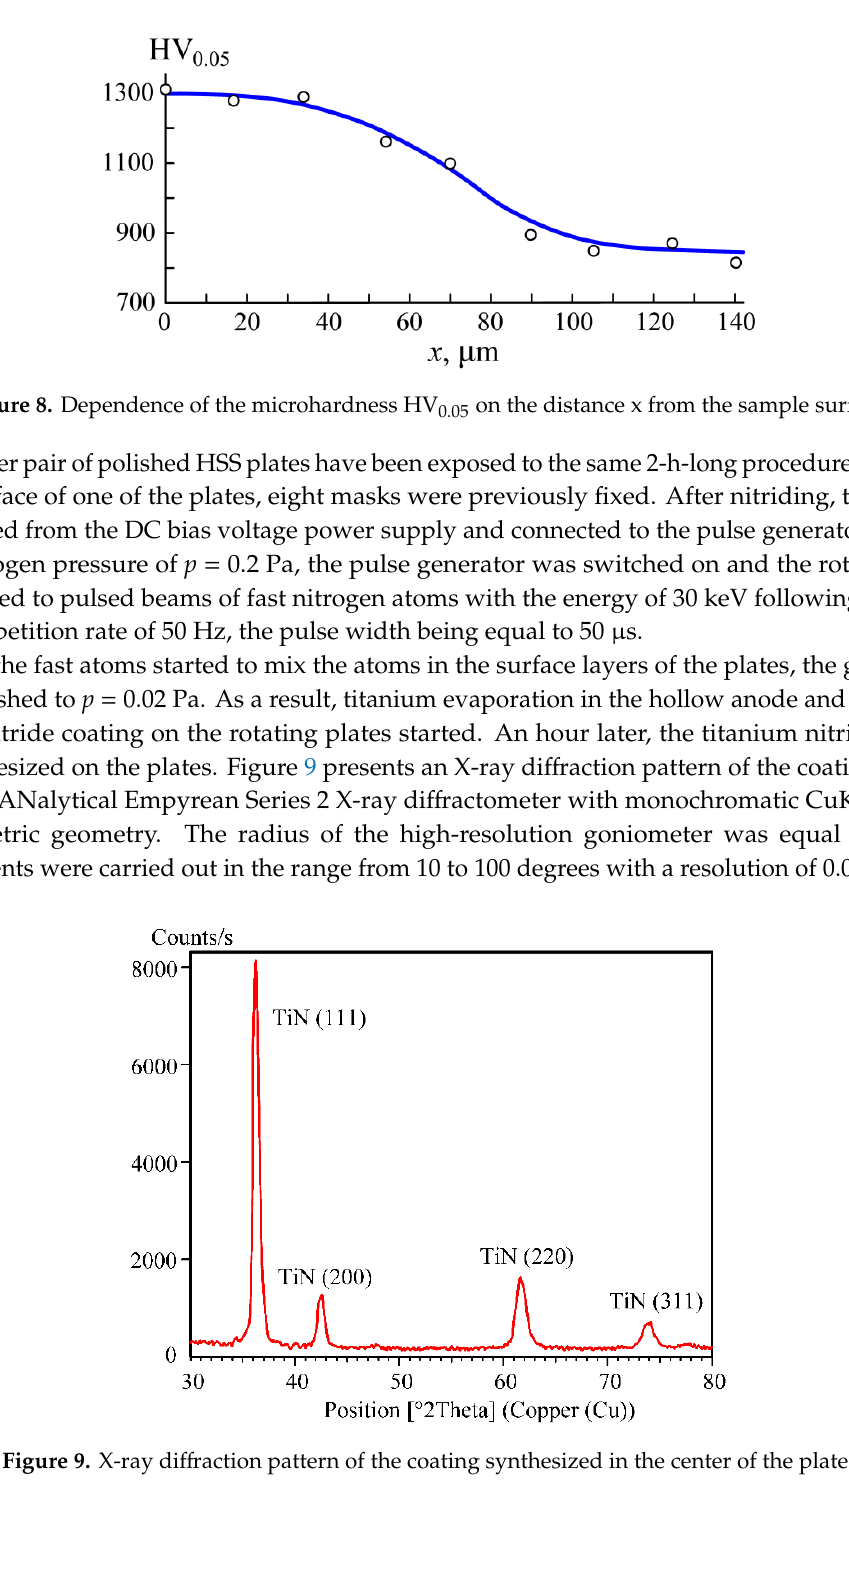
Figure 9. X-ray di ff raction pattern of the coating synthesized in the center of the Figure 9 . X-ray diffraction pattern of the coating synthesized in the center of the plate.